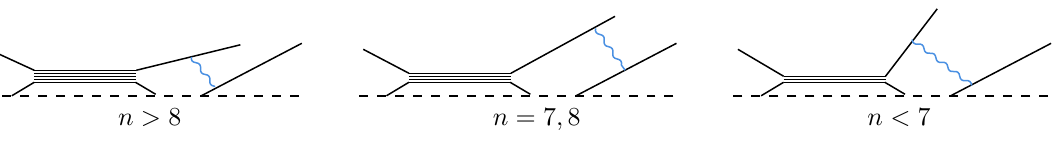
Figure 2 . (Left-panel) SO(7) gauge theory with a spinor matter. (Right-panel) SO(8) gauge theory with spinor and conjugate spinor matters.